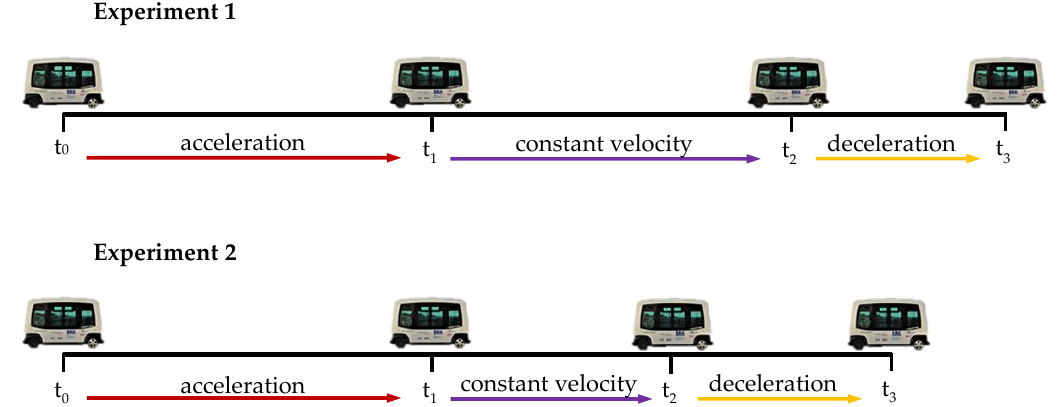
Figure 4. Examples of timing in two different experiments. Constant velocity (between t 1 and t 2 ) in Experiment 1 is longer than in Experiment 2. t 0 : start time (v = 0 m/s); t 1 : target velocity is reached (v = 4,17 m/s); t 2 : random braking time (v = 4,17 m/s); t 3 : finish time (v = 0 m/s).